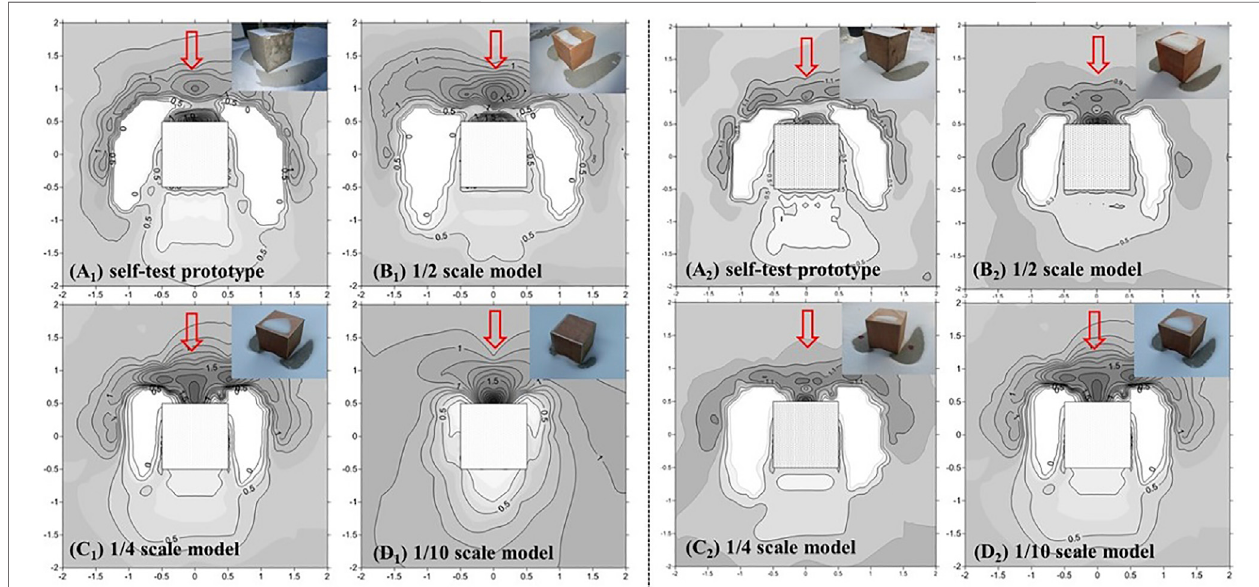
FIGURE 6 | Comparison of the snow distribution patterns of experiments using two different similarity criteria. (A1, B1, C1, D1) based on the densimetric Froude number similarity criteria and (A2, B2, C2, D2) based on the new Froude number similarity criteria proposed in this paper.